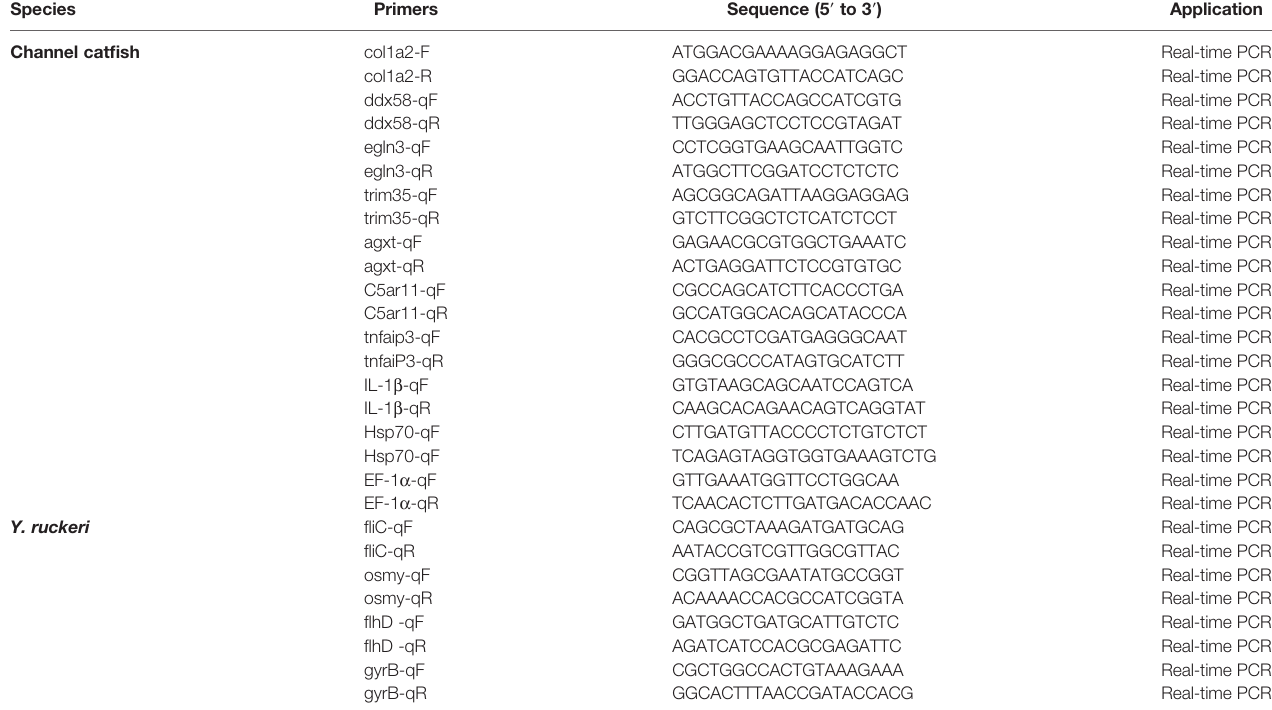
TABLE 1 | Oligonucleotide primers used in qRT-PCR for DEG validation. Species Primers Sequence (5 ′ to 3 ′